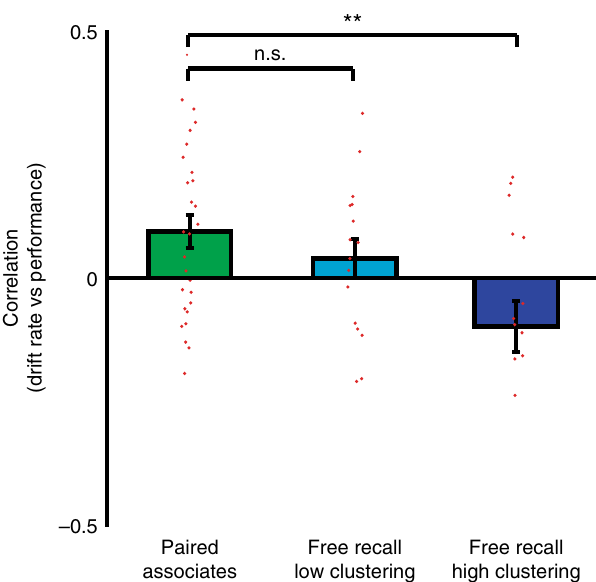
Fig. 3 Differences between tasks, according to behavioral patterns of retrieval in free recall. For each free recall participant, we quanti fi ed the degree to which recalled items tended to be linked across time. For each participant, we computed a temporal factor by fi rst assigning to each recall transition a number representing the degree to which each transition was temporally linked or unlinked. The temporal factor was de fi ned as the average value